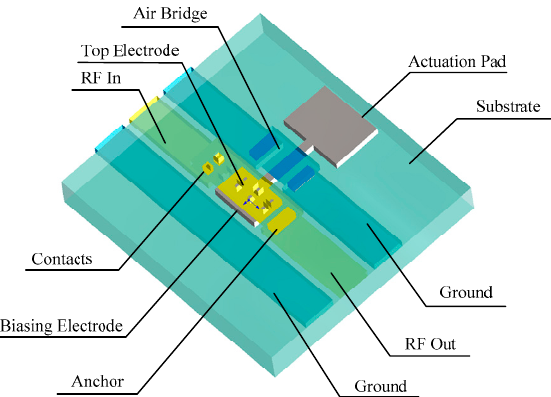
Figure 1. Structure of the RF MEMS switch.